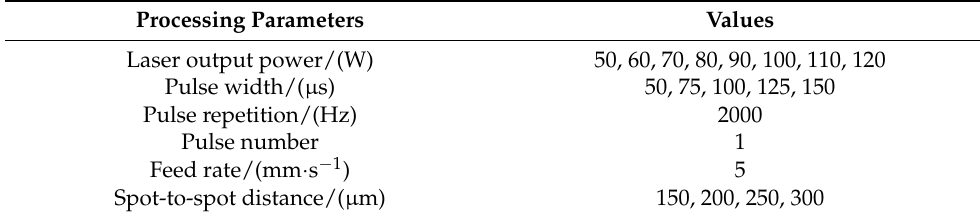
Table 3. Laser-processing parameters used in the experiment.